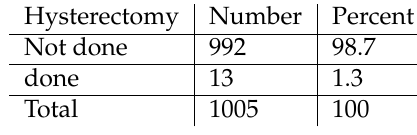
Table 3. number of subjects undergoing Pap smear and having History of hysterectomy